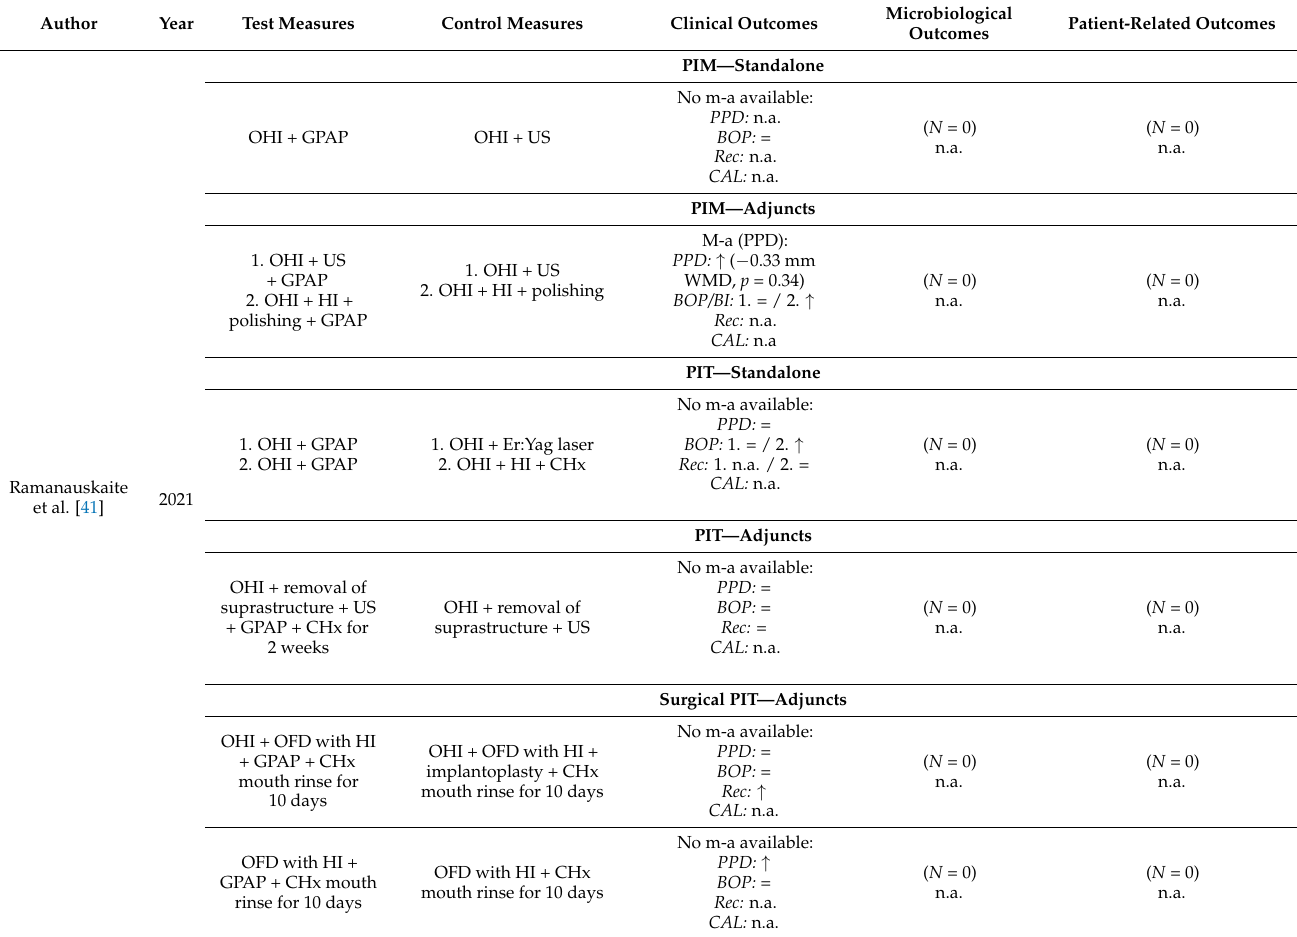
Control Measures Clinical Outcomes Microbiological Outcomes Patient-Related Outcomes